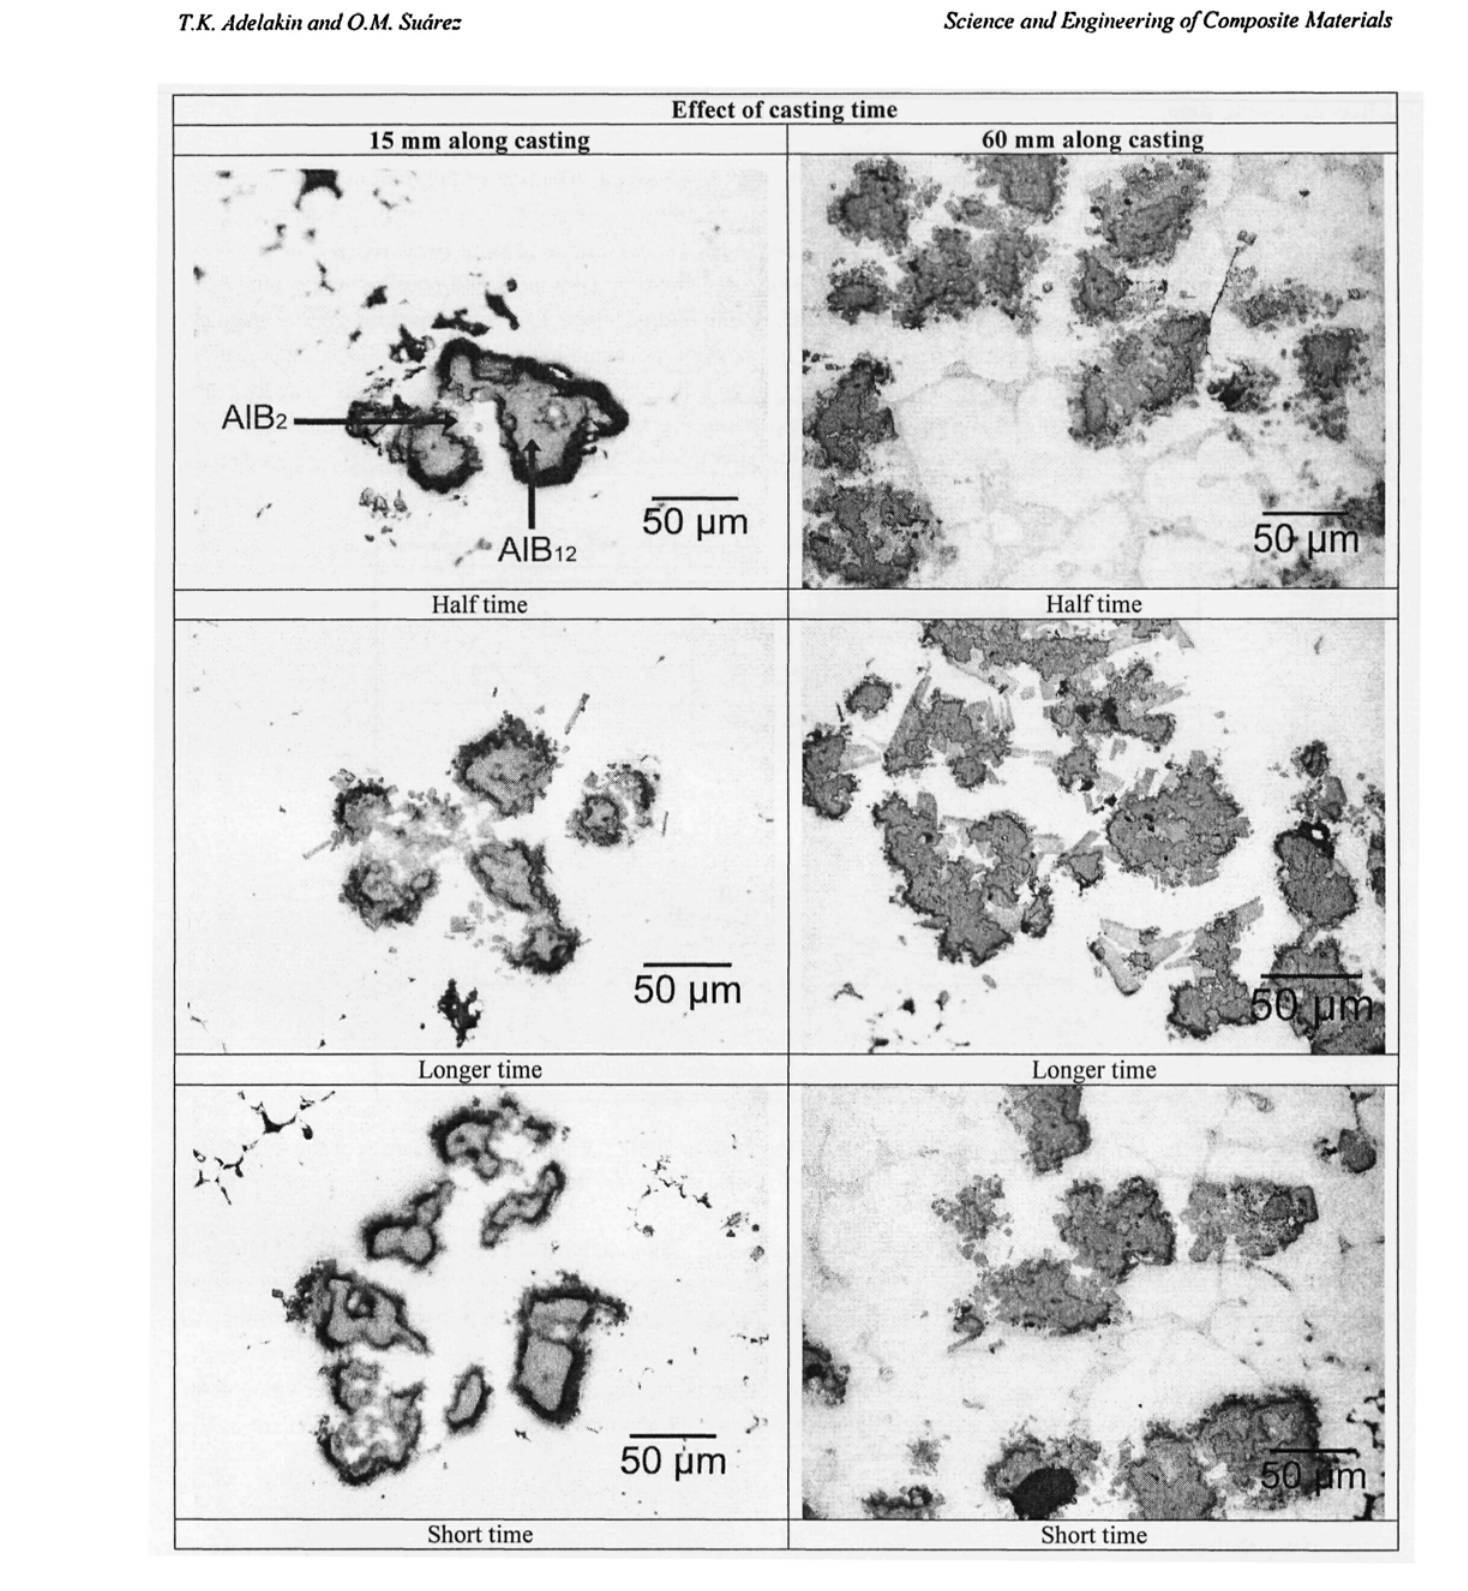
Fig. 3: Photomicrographs of as-cast microstructures of Al-B-Mgalongthe main axis of the cylindrical castings showing the effect of casting